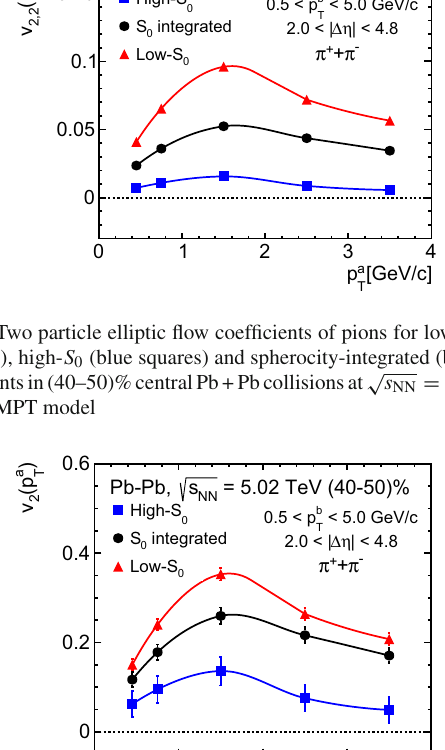
Fig. 5 Single particle elliptic flow coefficients of pions for low- S 0 (red triangles), high- S 0 (blue squares) and spherocity-integrated (black cir- cles)eventsin(40–50)%centralPb+Pbcollisionsat using AMPT